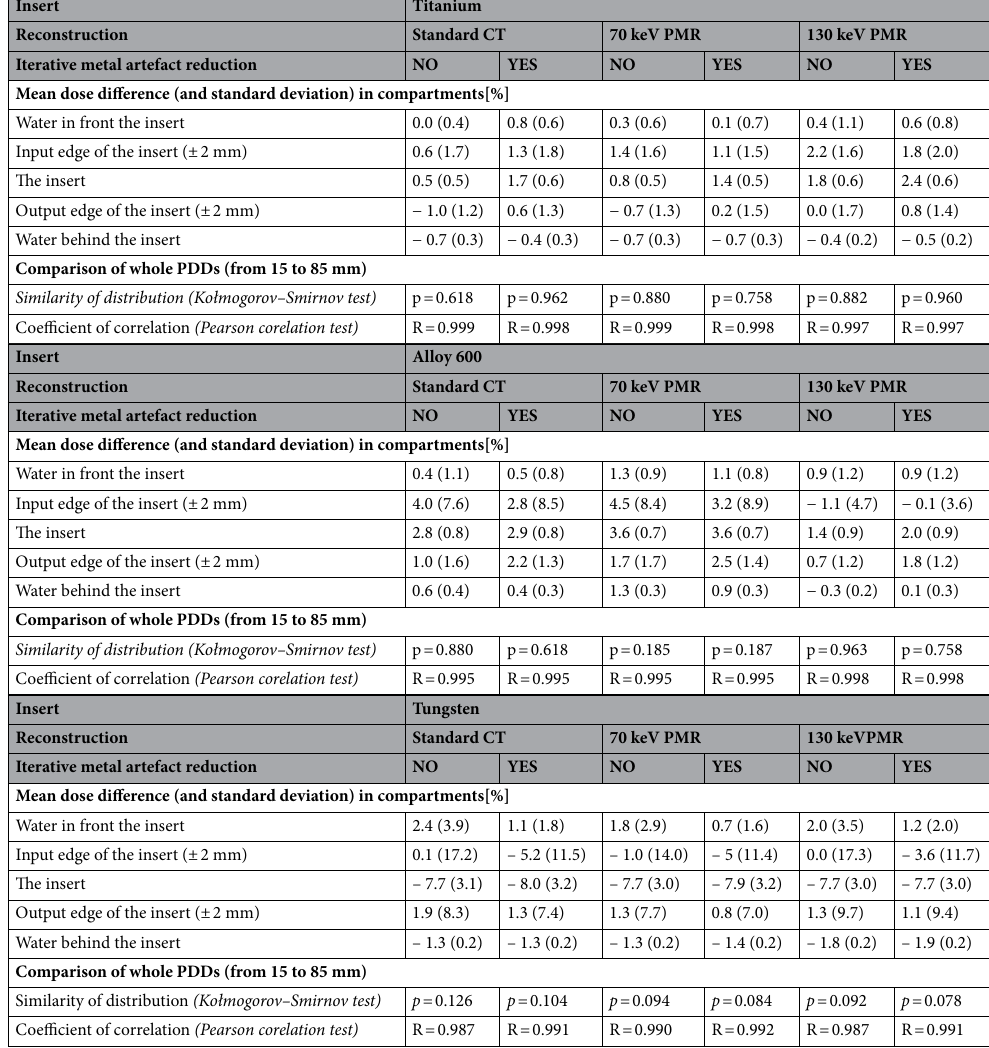
Table 2. The statistics of similarity between calculated (AXB DM : Acuros XB; dose-to-medium approach) and simulated (MC pla : Monte Carlo; TPS conditions) percentage depth doses, and mean dose difference (AXB DM – MC pla ) for selected regions of comparison.